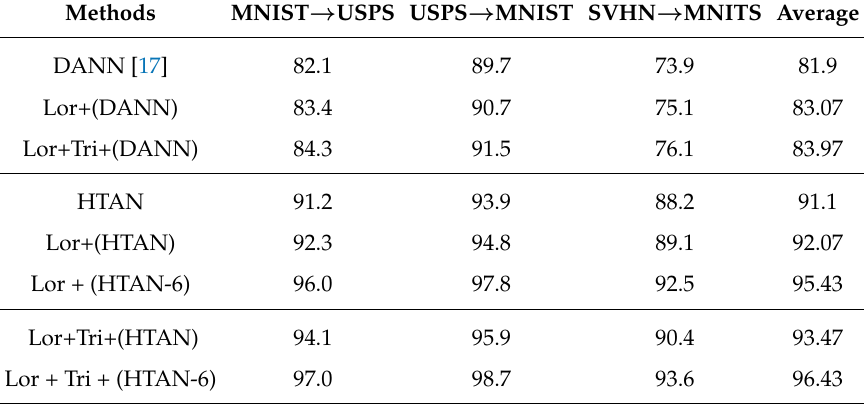
Table 4. Accuracy(%) of different methods on Digits dataset